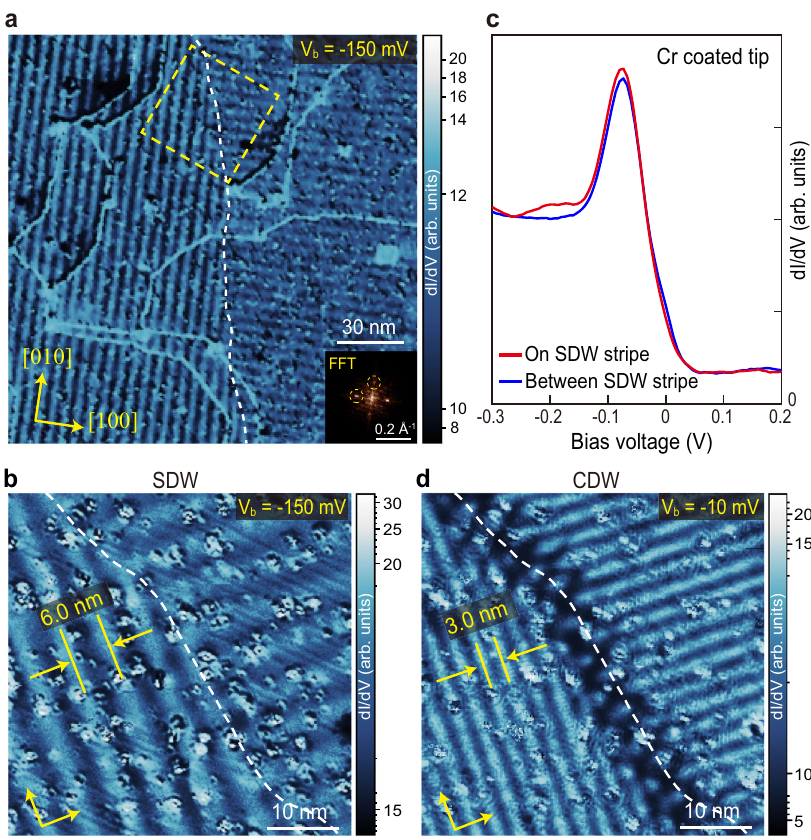
Fig. 2 Spin and charge modulations observed on Cr (001) surface. a The d I /d V map of the same area that shown in Fig. 1c, taken by a Cr coated spin- polarized tip at V b = − 150 mV ( I = 80 pA, Δ V = 20 mV). Inset: FFT image, dashed circles indicate the spots from spin modulations. b A zoom-in d I /d V map of the marked square in a , which shows spin modulation with a period of 6.0 nm. White dashed curve tracks the domain wall ( V b = − 150 mV, I = 150 pA, Δ V = 15 mV). c Typical d I /d V (point spectra) taken on and in between the spin modulation stripes (setpoint: V b = 1 V, I = 60 pA, Δ V = 20 mV). d d I /d V map of the same area as b , but taken at V b = − 10 mV. The charge modulation with a period of 3.0 nm is observed ( I = 150 pA, Δ V = 5